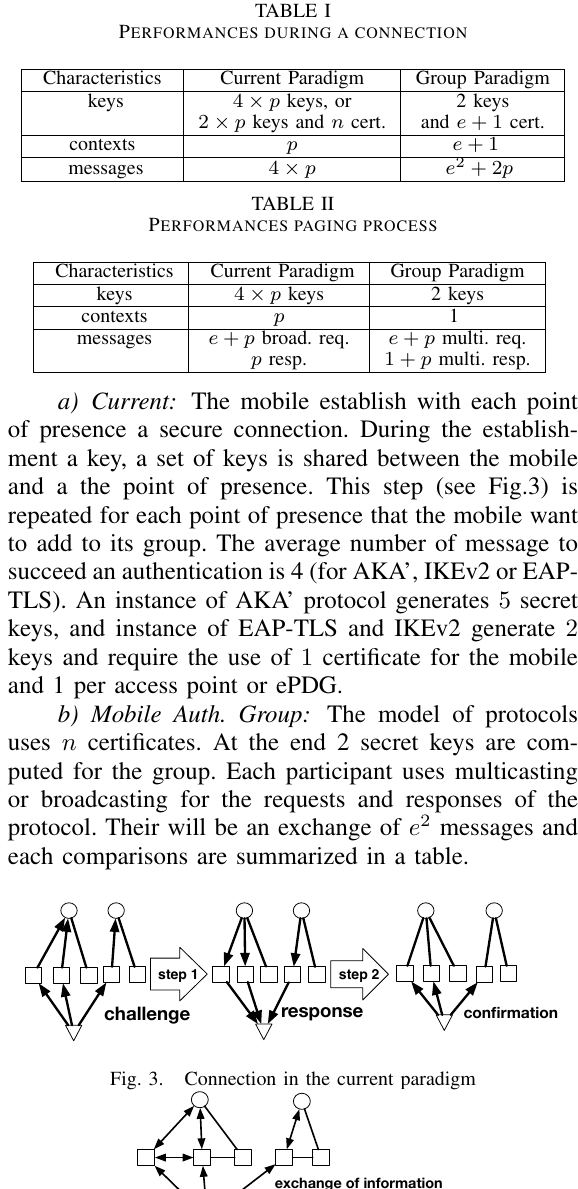
exchange of information between all the members Fig. 4. Connection in the authenticated group